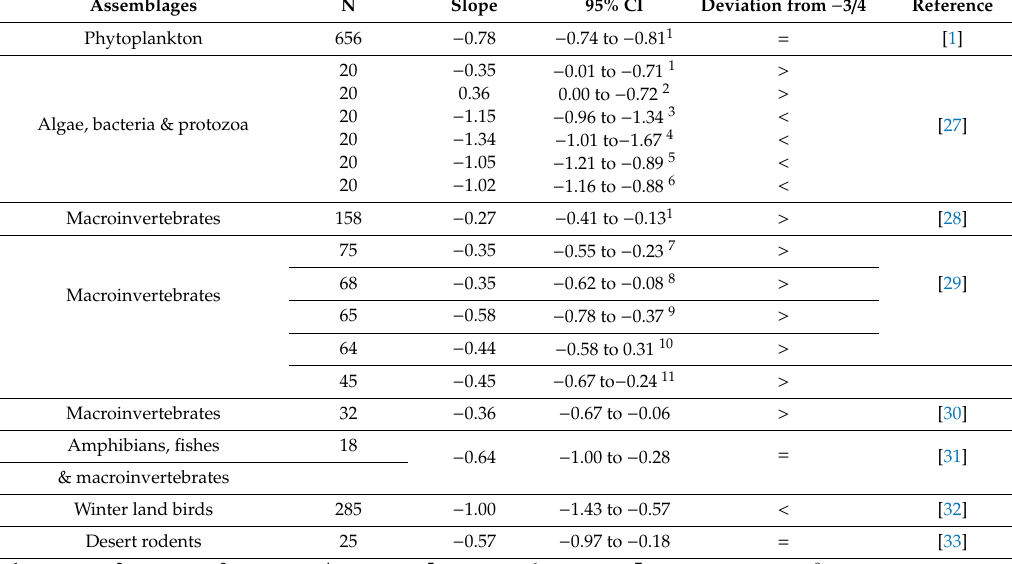
Table7. CCSRslopesforvariouscommunityassemblagesofspecies, includingfield(e.g., phytoplankton, macroinvertebrate, amphibian, fish, bird and rodent assemblages) and experimental studies (e.g., algae, bacteria and protozoa) reported in the literature. 95% confidence intervals and significant deviation of the slopes from the theoretical expected value of − 3 / 4 are also